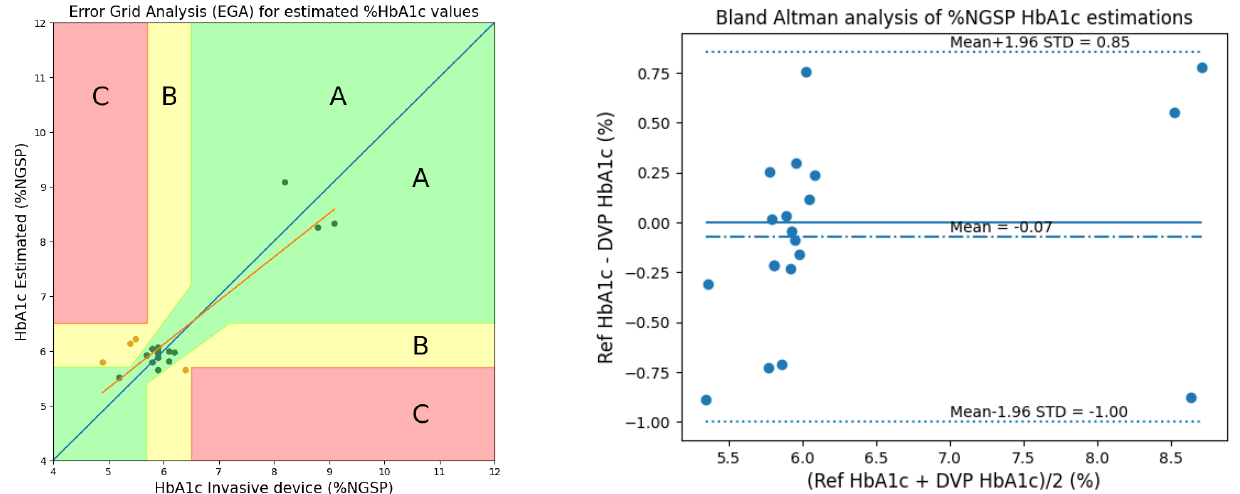
Figure 6. EGA and Bland–Altman analysis for HbA1c with the whole finger model (considering ratio calibrations only).